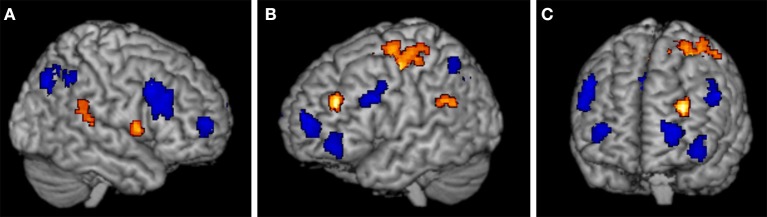
Regions with significant activation differences in (A) the right cortex, (B) the left cortex, and (C) frontal cortex, with threshold p < 0.0001 (cluster level: p < 0.05, FWE). Regions that were more highly activated in the exemplar task are shown in blue, regions that were more highly activated in the mapping task are in orange.